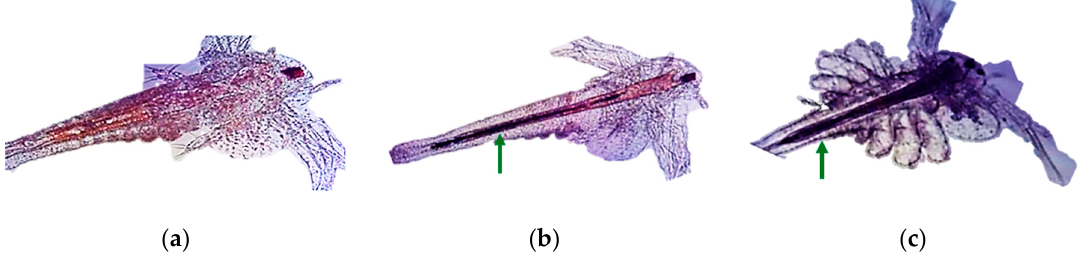
Figure 27. Light microscope images of ( a ) control, ( b ) pristine graphene monolayer flake (PGMF) and ( c ) graphene nanopowder grade C1 (GNC1-)treated Artemia salina (24 h exposure, 1.25 mg / L. Arrows indicate the presence of PGMF or GNC1 in the gut. (Modified after [141]). After a 96-hour co-exposure to Cu and GO, the roots of duckweeds were covered with GO fragments (Figure 28). GO significantly decreased the nutrient contents of L. minor only at concentrations of at least 5 mg / L